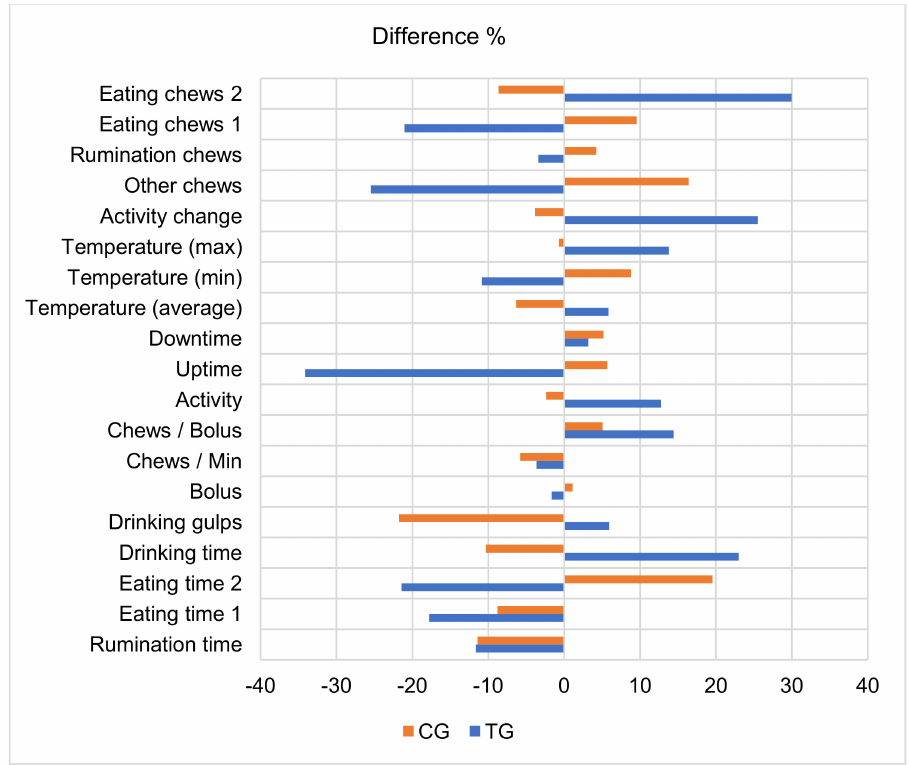
Figure 2. Comparison of parameters of rumination behavior during the last 30 days before calving and the first 30 days after calving. The differences between the mean values of the periods (period: the last 30 days before calving = 100 %) are statistically significant. TG—subclinical ketosis group; CG—control